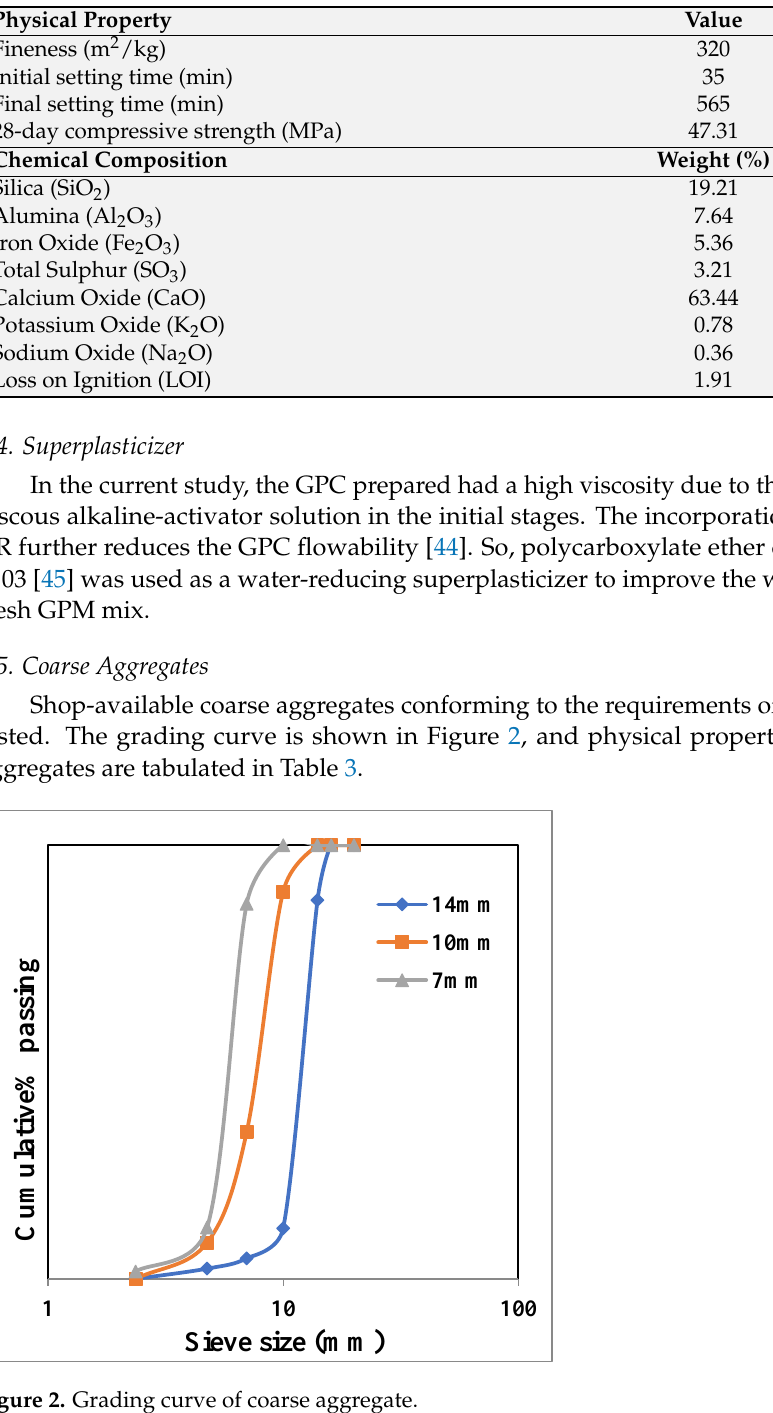
Table 2. Physical properties and chemical composition of OPC.